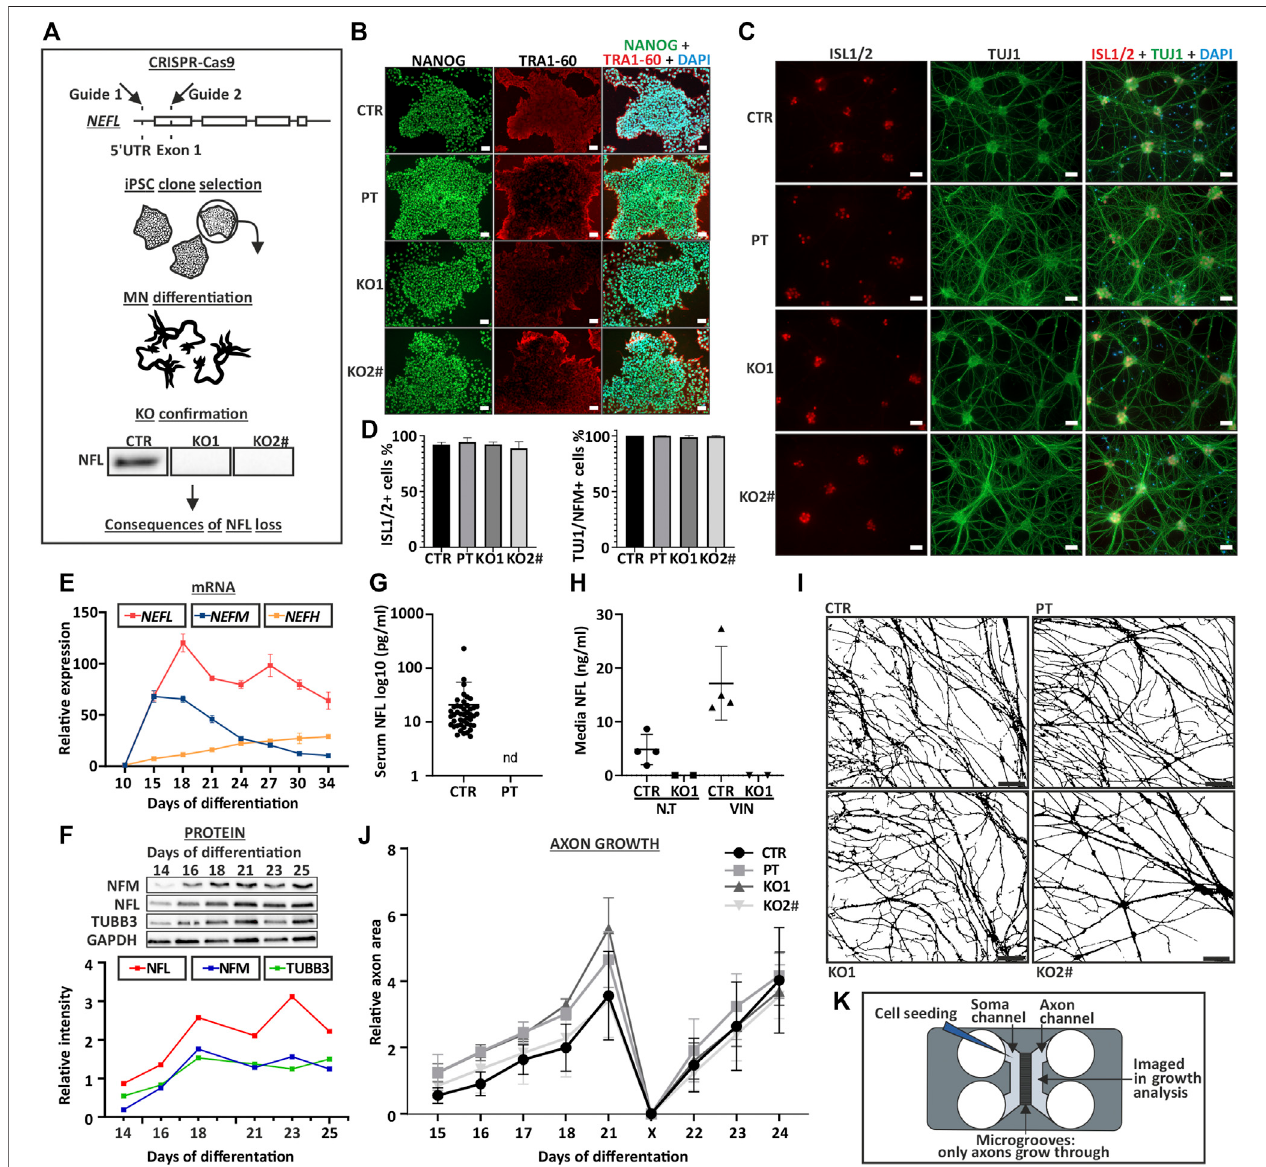
FIGURE 1 | Characterization of NEFL KO iPSC and motor neurons. (A) NEFL was knocked out from control iPSC with two guides targeting 5 ′ UTR and Exon 1. iPSC clones were selected for differentiation. KO candidates were differentiated into motor neurons and absence of full-length NFL was con fi rmed by immunoblotting. Celllineswithnosignalinimmunoblottingwereused forfurtherassays. (B) NEFL KOand patient(PT)iPSClinesarepluripotent.Control(CTR), NEFL KO(KO1andKO2) andPTiPSCexpresspluripotencymarkersNANOG(green)andTRA-1-60(red),analyzedbyimmunocytochemistry(nucleicounterstainwithDAPI,blue).Scalebar 50 µm. (C) KOandPTiPSCdifferentiatewithsimilaref fi ciencyastheisogeniccontrol.Differentiationef fi ciencyofDay35motorneuronswasassayedbycountingISL1/2 (red)positiveandTUJ1(green)orNFM(notshown)positivecellsinimmunocytochemistry.DAPIcounterstain(blue).Scalebar50 µm. (D) Quanti fi cationofC.Average% ofpositivenuclei/cytoplasmwithstandarddeviation(SD).Sixreplicatesfromthreeindependentdifferentiationswith18frames.One-wayANOVAfollowedwithDunnett ’ s multiple comparison post hoc test vs. CTR. p > .05. (E) NEFL , NEFM, and NEFH mRNA expression during differentiation. N = 2-3 per time-point. Normalized to ACTB expression andtoday10expressionofrespectivegene. (F) NFL,NFM, andTUBB3proteinlevelsduring differentiation. NormalizedtoGAPDHsignalintensity. N =1per time-point. (G) NFL measurement by Simoa from serum of control individuals and PT. Each dot indicates an individual sample [control values are the same as in (Järvilehtoetal.,2021)].Nd=notdetectable.AveragewithSD(pg/ml). (H) NFLmeasurementbySimoafromiPSC-MNculturemedia.Treatmentwiththeneurotoxicdrug vincristine (VIN), which induces axonal degeneration was used as a positive control. N.T = not treated. CTR n = 4 and KO1 n = 2. Average with SD (ng/ml). (I) Axonal growth is not affected by NFL loss. Masks of phase contrast images of day 21 motor neuron axons in a micro fl uidic device (Xona, 450 μ m). Scale bar 100 µm. (J) Quanti fi cation of image I. axon area on axonal side of micro fl uidic device. Axonal growth and regrowth after mechanical axotomy is not affected by NFL loss. Average relativeareaofaxonalcoverageandSEM. n =3independentexperiments/celllinewith5framesanalyzedpertimepoint.Growthnormalizedtoaverageday15axonarea per experiment. X indicates axotomy. Two-way ANOVA followed withTukey ’ smultiple comparison post hoctest p > .05. (K) Schematic ofamicro fl uidicdevice used for axon analysis. # indicates abnormal